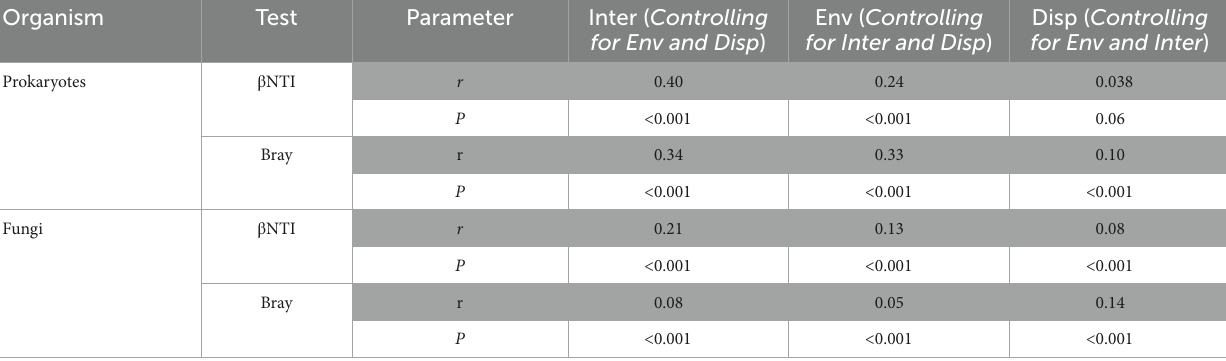
FIGURE 6 (A) Mantel correlations between bray–curtis dissimilarity and β NTI of microorganism and the distance matrix of environmental variables (Env), geographic distance (Disp) and biotic interactions (Inter); (B) The variation partition analysis of prokaryotic and fungal communities that can be explained by environmental filtering (Env), dispersal limitation (Disp) and biological interactions (Inter).